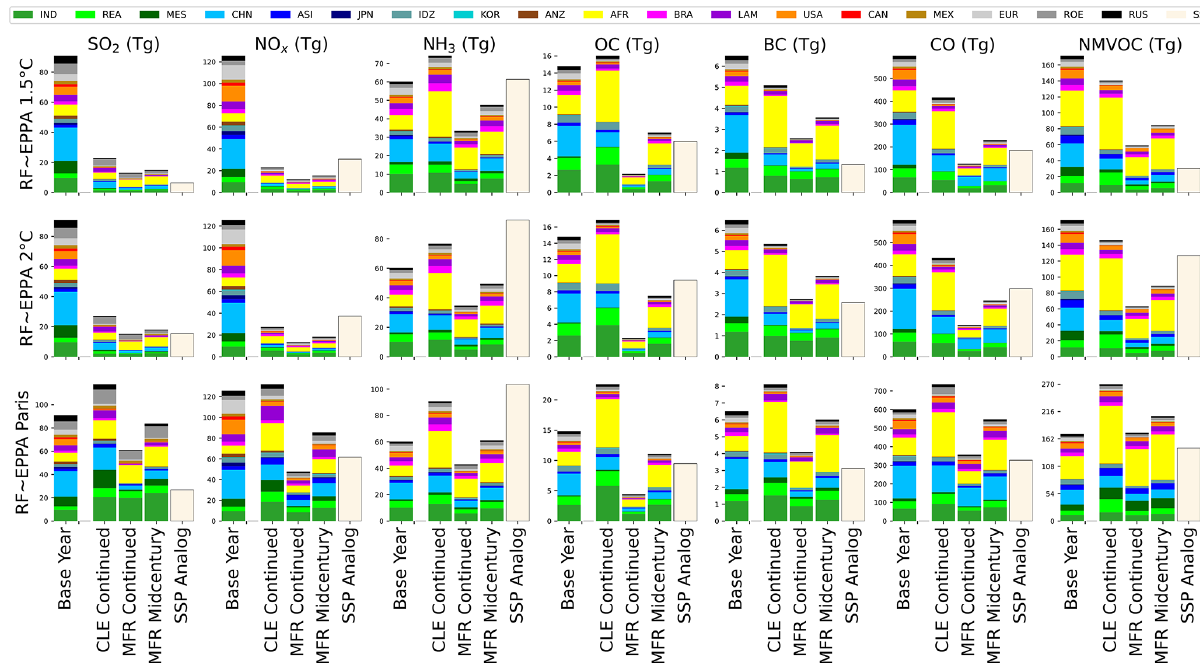
Figure 6. Same as Fig. 5 but for 2100, and including the MFR Mid-century scenario in Table 3. Table 4. Summary of pathways